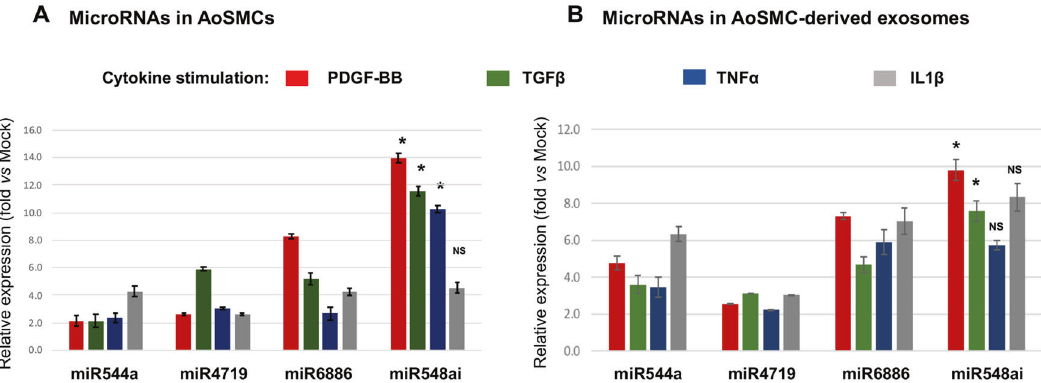
Fig. 4 qRT-PCR determination of cytokine-stimulated upregulation of SMC-derived exosomal microRNAs. AoSMC culture, cytokine stimulation, and exosome isolation were performed as described in Fig. 1. qRT-PCR was performed to detect cytokine-induced level changes of the four microRNAs selected in Fig. 3. Levels of microRNAs in either cytokine-stimulated AoSMCs or AoSMC-derived exosomes were measured, as shown in A and B , respectively. The relative expression refers to microRNA fold change with (vs. without) cytokine stimulation. Data are presented as mean ± SD ( n = 3 replicates). * P < 0.05, miR548ai compared to any of the other three microRNAs (between two bars of the same color), as analyzed with one ‐ way ANOVA followed by Bonferroni post hoc test; NS not signi fi cant.